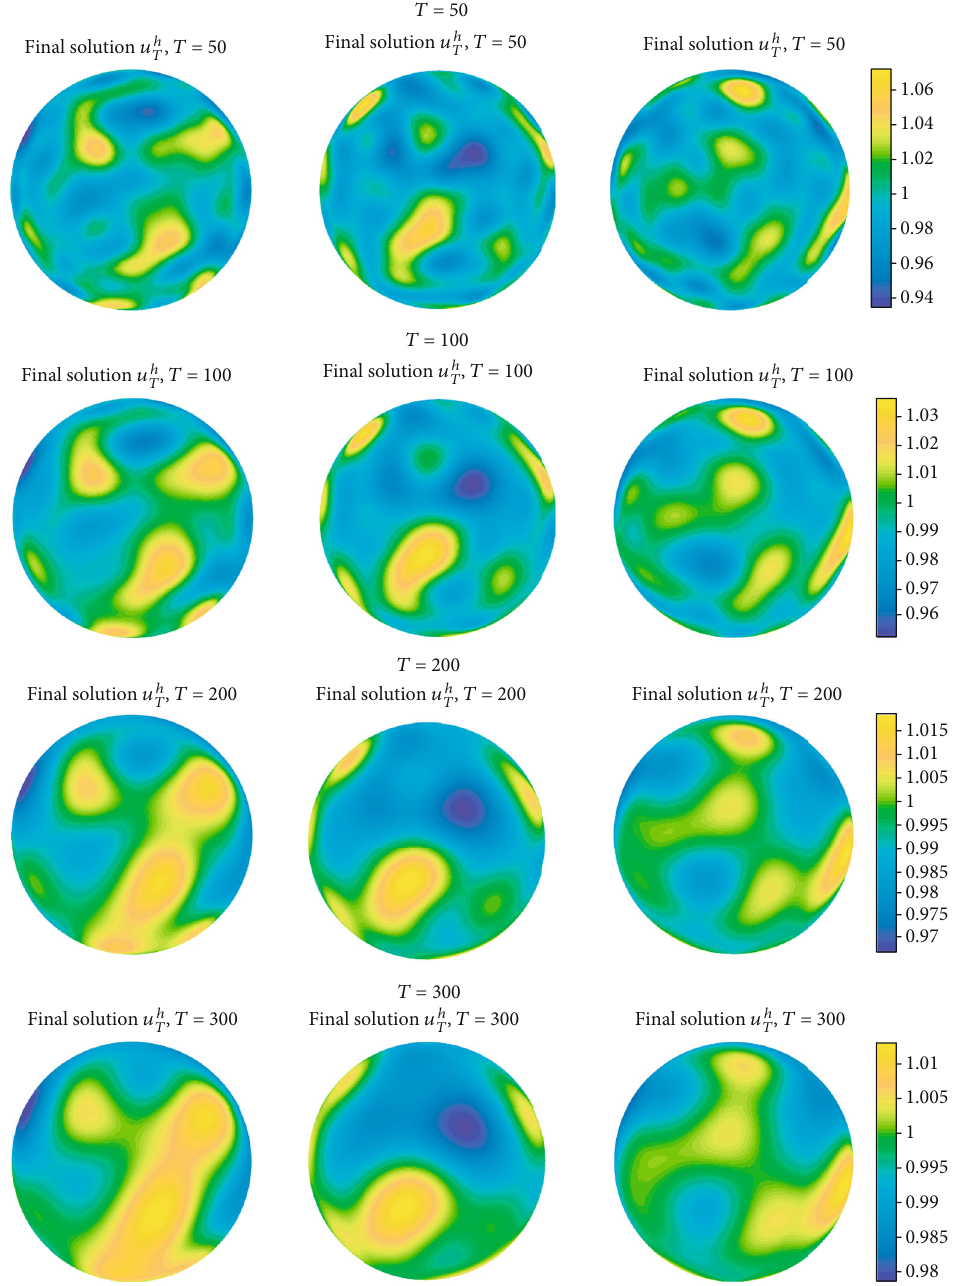
= 1/20 , D = 1 , a = 0 : 1 , and b = 0 : 9 u v